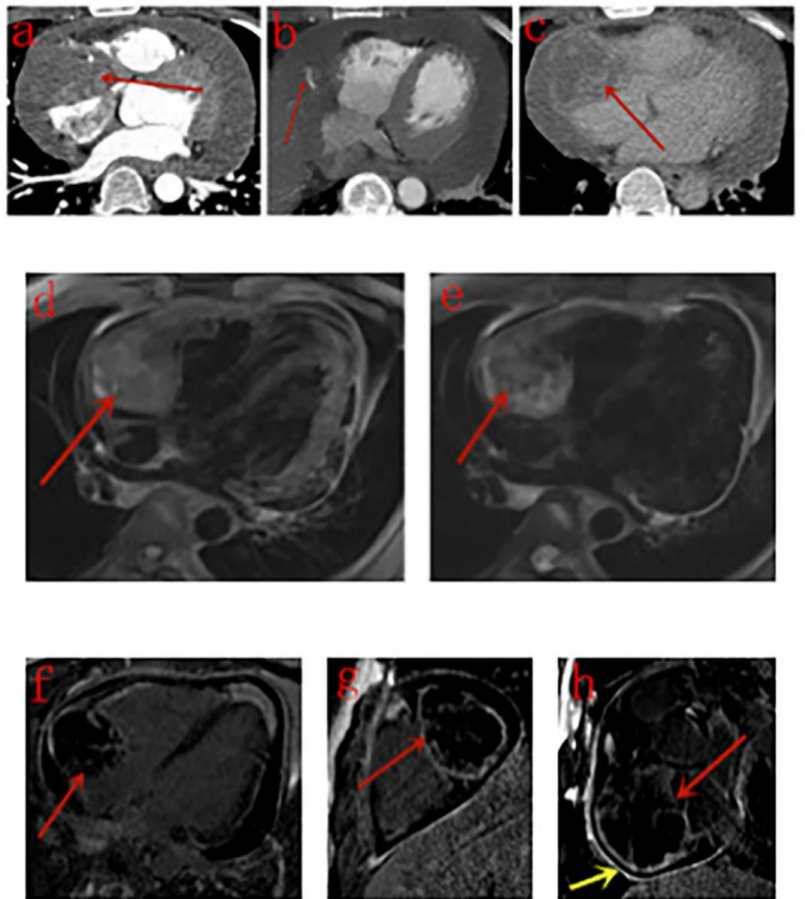
Figure 2. Male, 34 years old, right atrium angiosarcoma. ( a – c ): The mass (red arrow) is heterogeneously enhanced in the arterial ( a ) and venous ( c ) phase of contrast-enhanced CT images, and small tortuous vessels ( b , red arrow) deriving from the right coronary artery (RCA) and pericardial e ff usion are noticed. ( d , e ): The mass (red arrow) presents as heterogeneous intensity, with multiple hyperintense hemorrhage foci on T1WI ( d ) and T2WI ( e ). ( f – h ): late-phase gadolinium enhancement (LGE) shows heterogeneous rim enhancement (red arrow) on four-chamber ( f ), two-chamber ( g ), and short axis ( h ) planes. Pericardium enhancement is noticed in the short axis plane (yellow